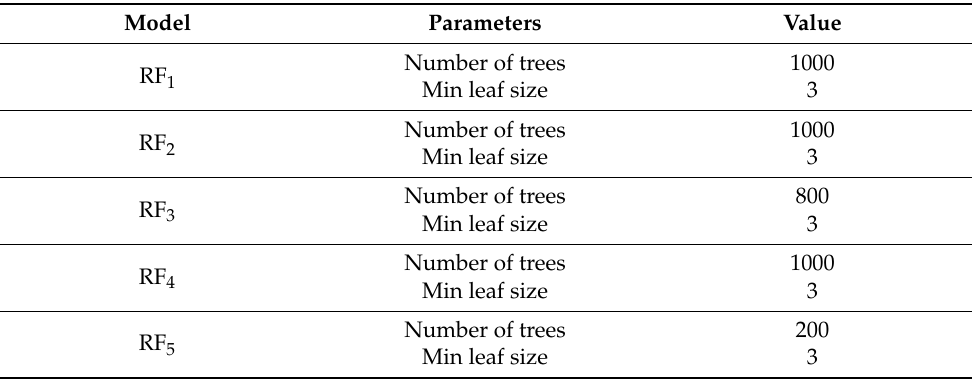
Table 4. Parameters for the single RF